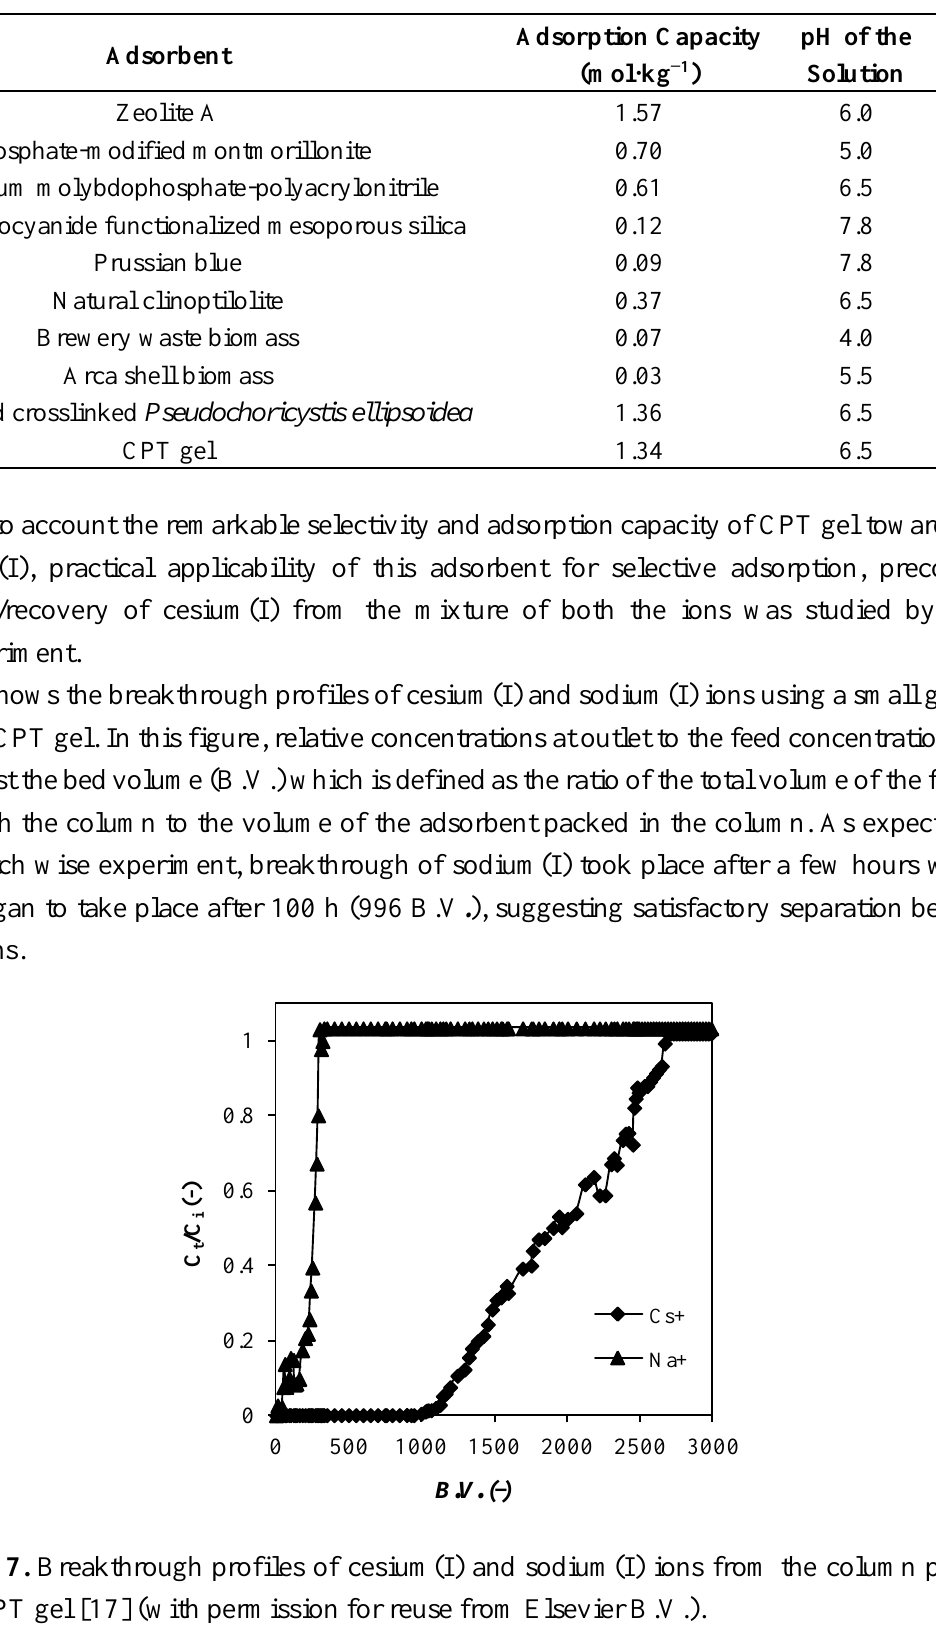
Table 1. Cesium(I) ion adsorption capacity comparison of the CPT gel and other adsorbents.